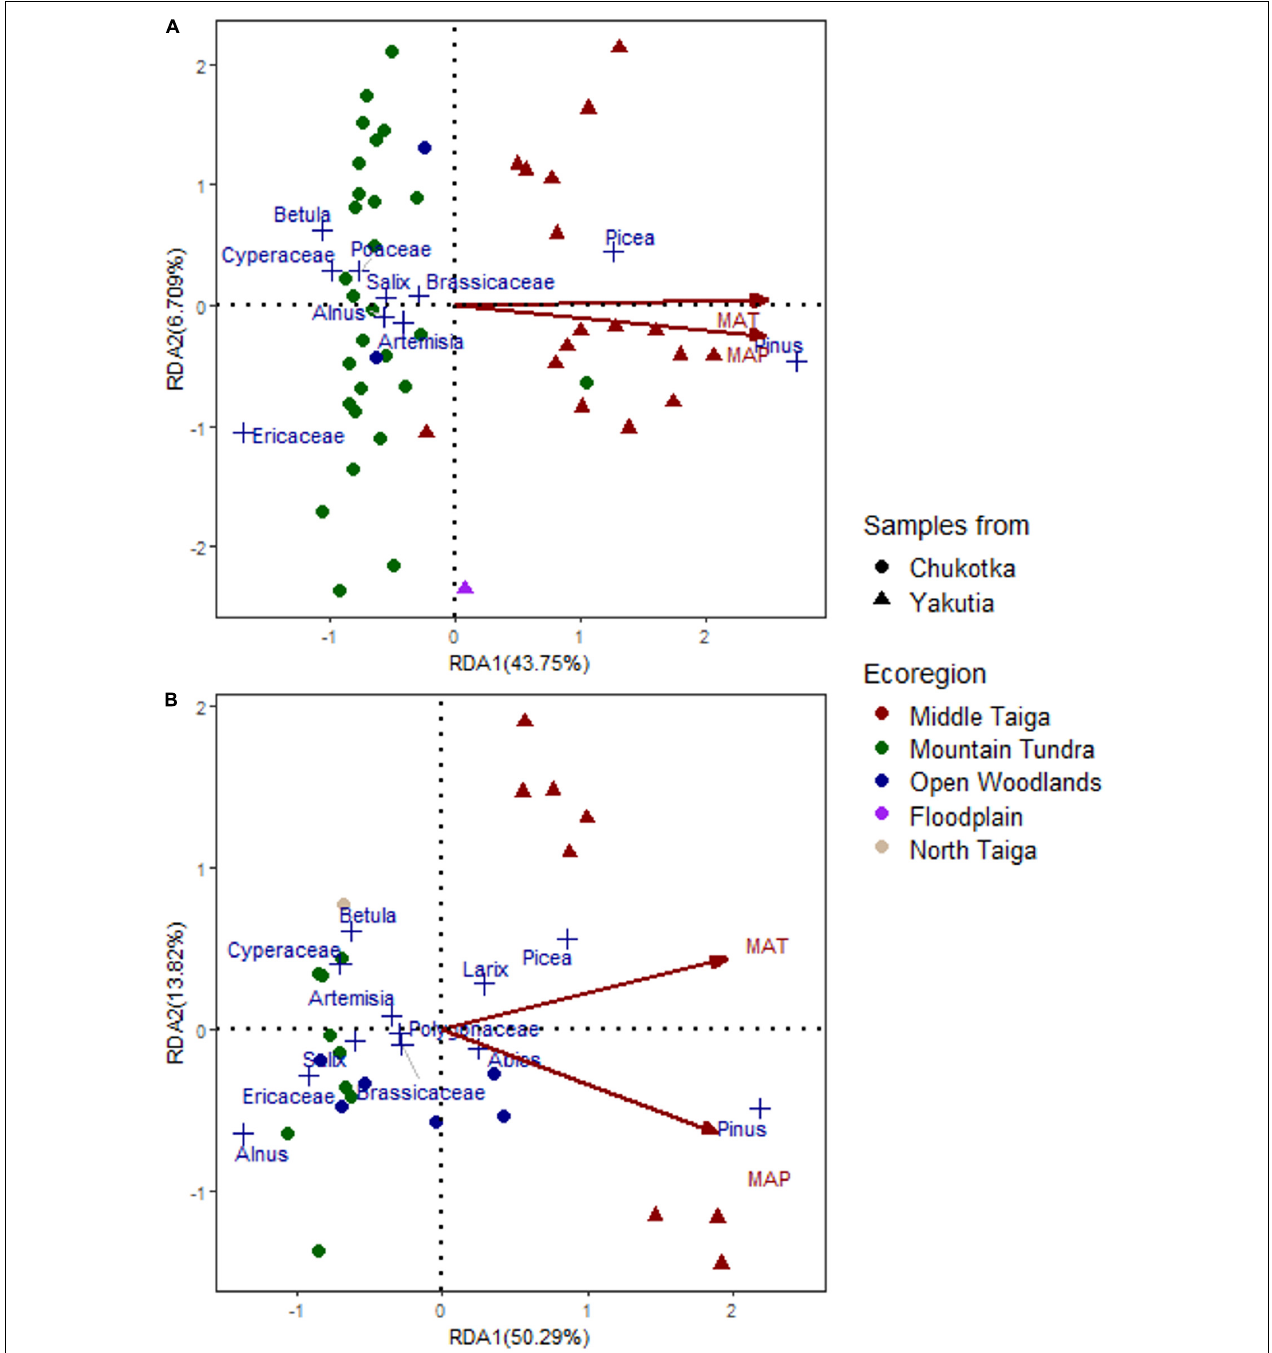
FIGURE 4 | Triplots of redundancy analysis (RDA) based on surface pollen data from (A) moss/soil samples and (B) lake samples. Climate variables are projected as red arrows in the plots (MAP, mean annual precipitation; MAT, mean annual temperature).